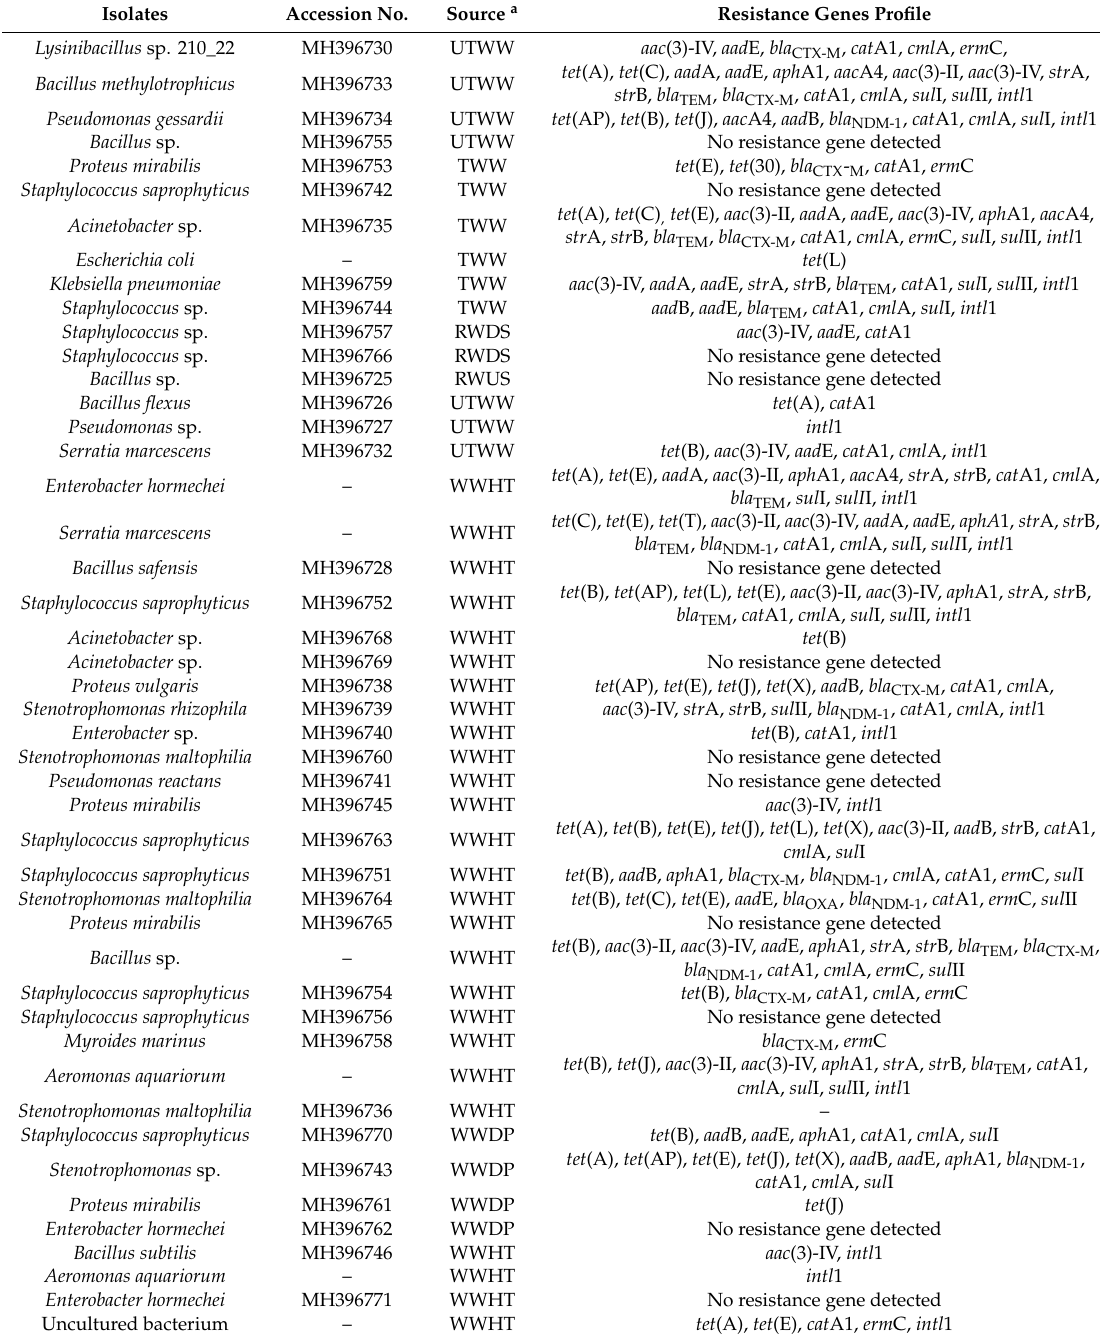
Table 1. Phenotypic pattern of antibiotics resistance and resistance gene profile of bacterial isolates.